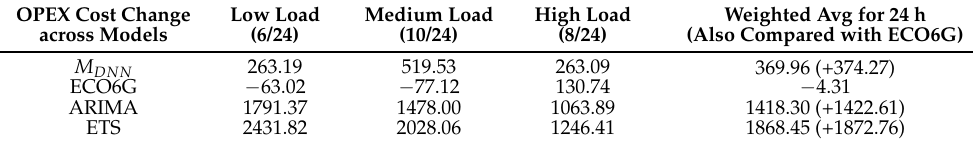
Table 6. OPEX Cost Change (in Million $) for MNO to operate ‘100,000’ BS for 5 year. OPEX Cost Change across